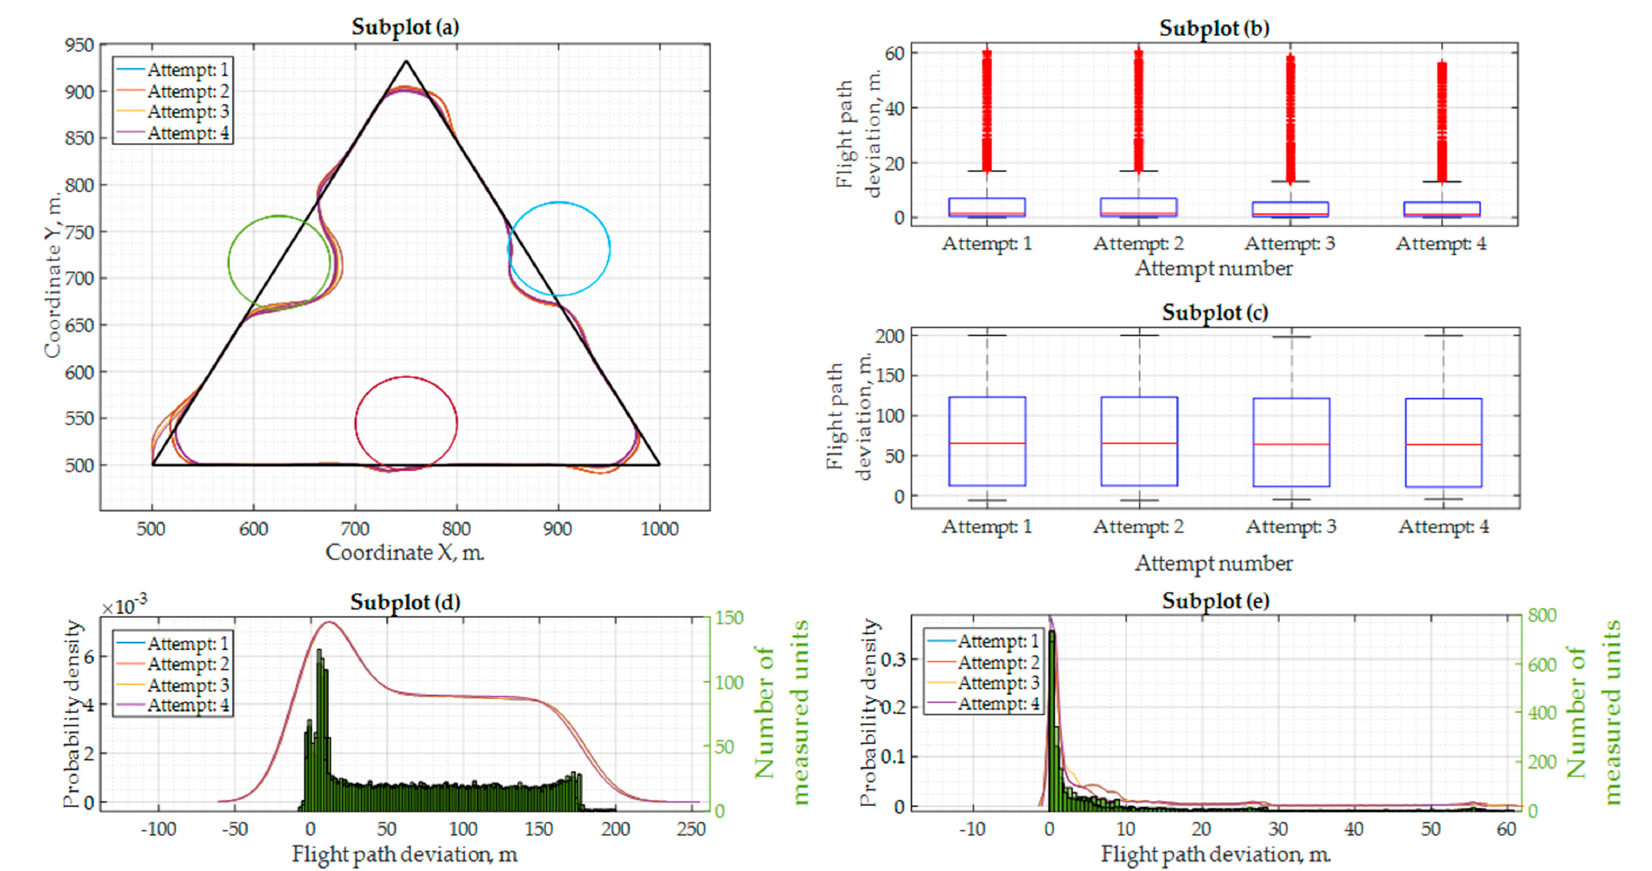
Figure 11. Results of the Software-in-the-Loop simulation with the “ArduPilot” autopilot with the flight speed at 10 m/s: ( a ) flight mission, flight trajectory and ground obstacles; ( b ) flight deviation from the standard flight mission path (when using ground obstacle avoidance); ( c ) flight deviation from the ground obstacle area boundary of 50 m. (when using ground obstacle avoidance); ( d ) probability density values and quantity of measurements for every flight path deviation value (standard mission); ( e ) probability density values and quantity of measurements for every flight path deviation value (from ground obstacle area